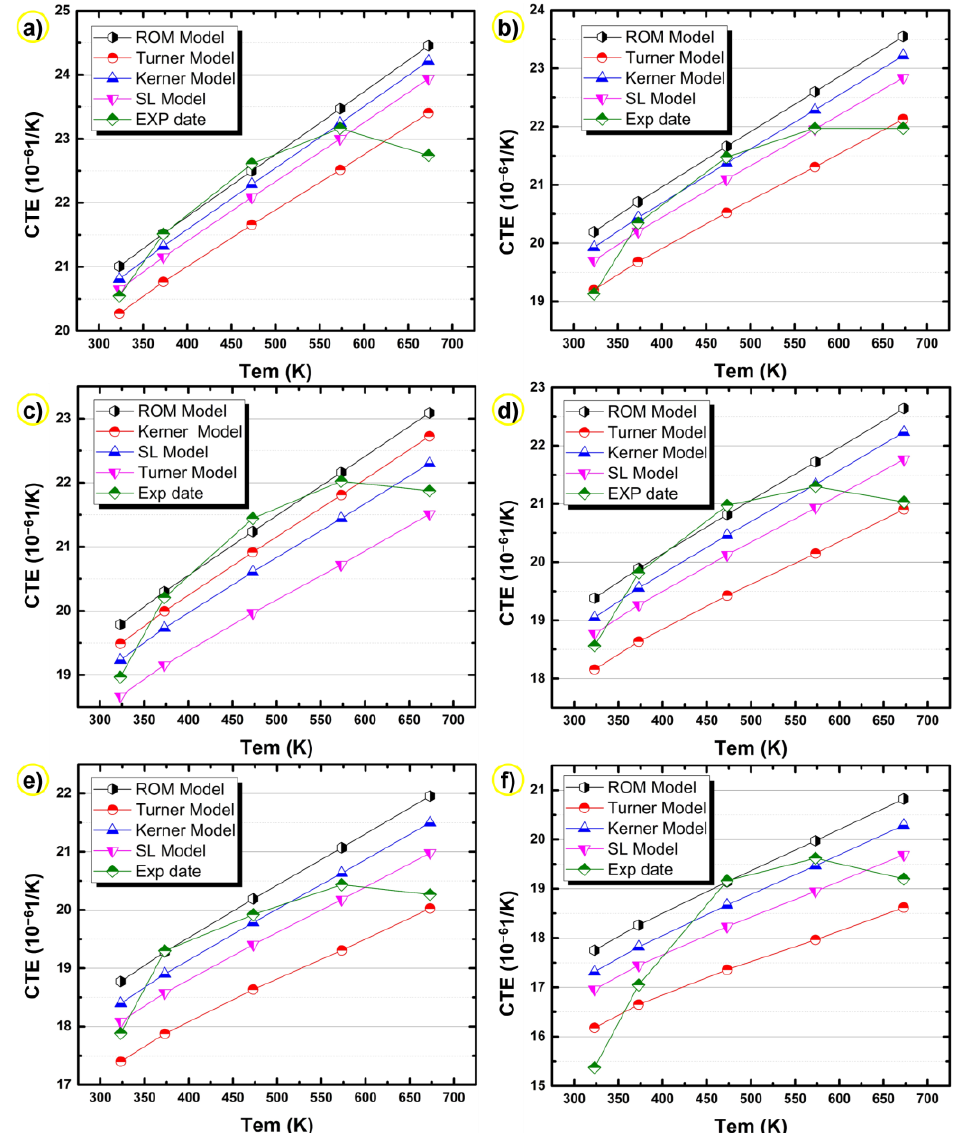
Figure 9. Comparison between theoretical and experimental CTEs for the bimetallic gradient alloy in different layers: ( a ) first layer, ( b ) second layer, ( c ) third layer, ( d ) fourth layer, ( e ) fifth layer, and ( f ) sixth layer.